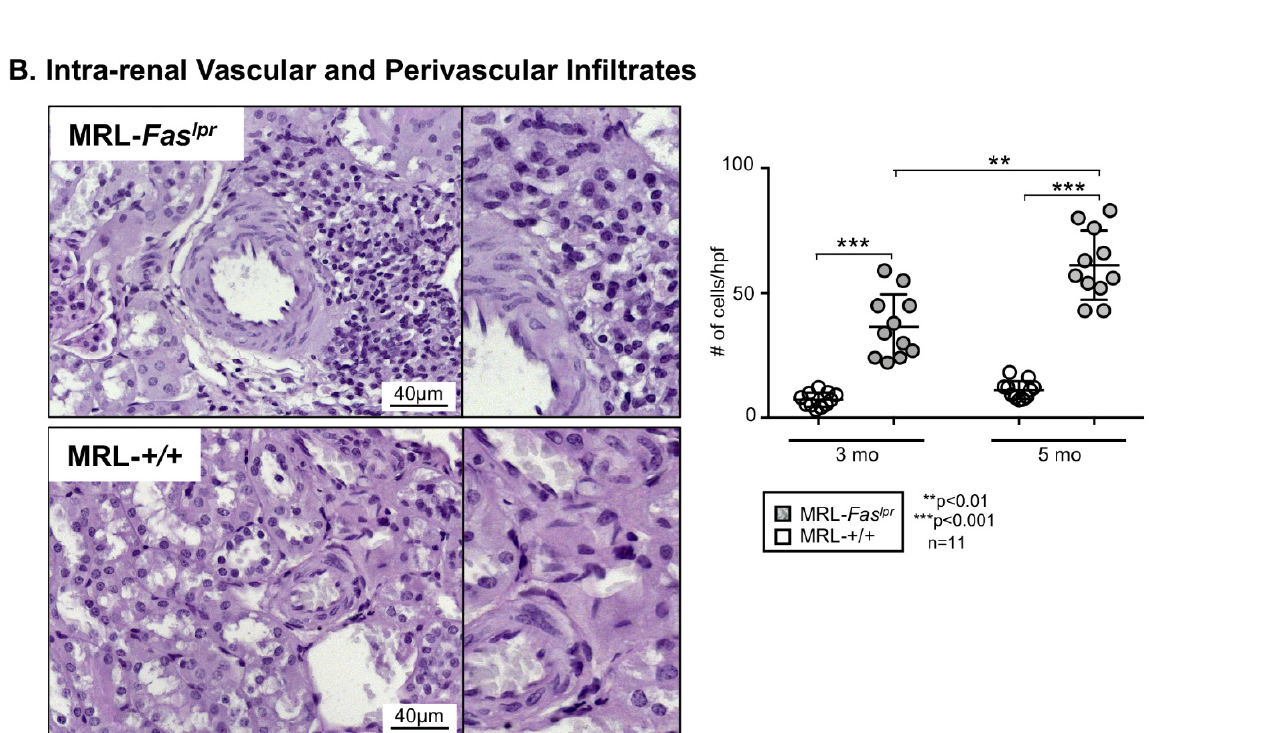
Figure 1. Dominant vascular manifestations on MRL- Fas lpr lupus mouse model. ( A ) Histopathological imaging of vascular infiltration in the kidney, lung, and salivary glands in 5-month-old MRL- Fas lpr mice. ( B ) Intra-renal evaluation of vascular and perivascular infiltrates in MRL- Fas lpr mice (3 and 5 mo of age) compared to MRL-++ mice (control strain), n = 11 (a single data refers to a single animal). Representative microphotographs are shown (magnification 40 × ). Values are means ± SEM. Statistical analysis using Mann–Whitney U Test. v, vascular lumen